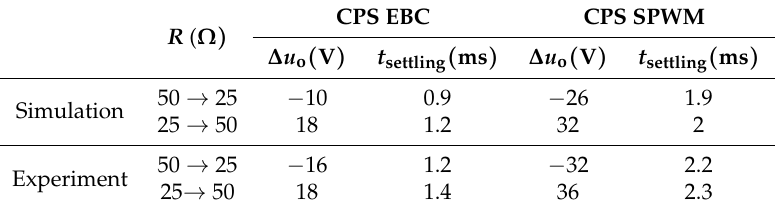
Table 4. Simulation and Experimental results under load